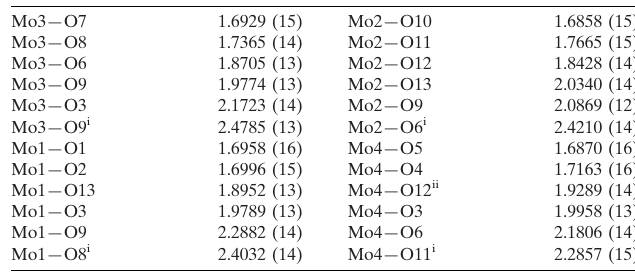
Selected bond lengths (A˚ ).